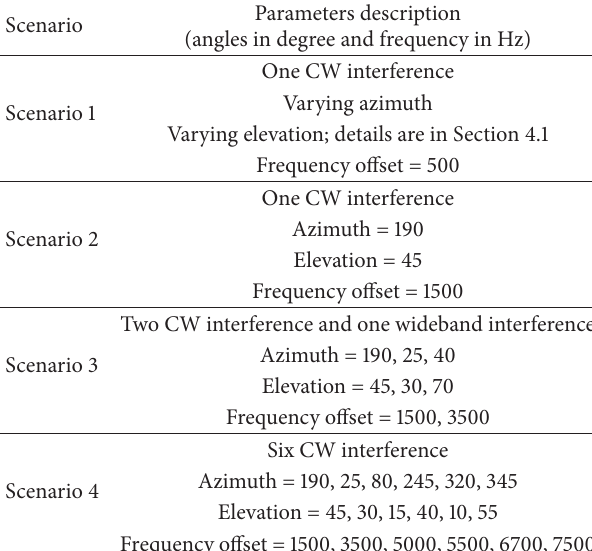
Table 3: Interference scenarios.